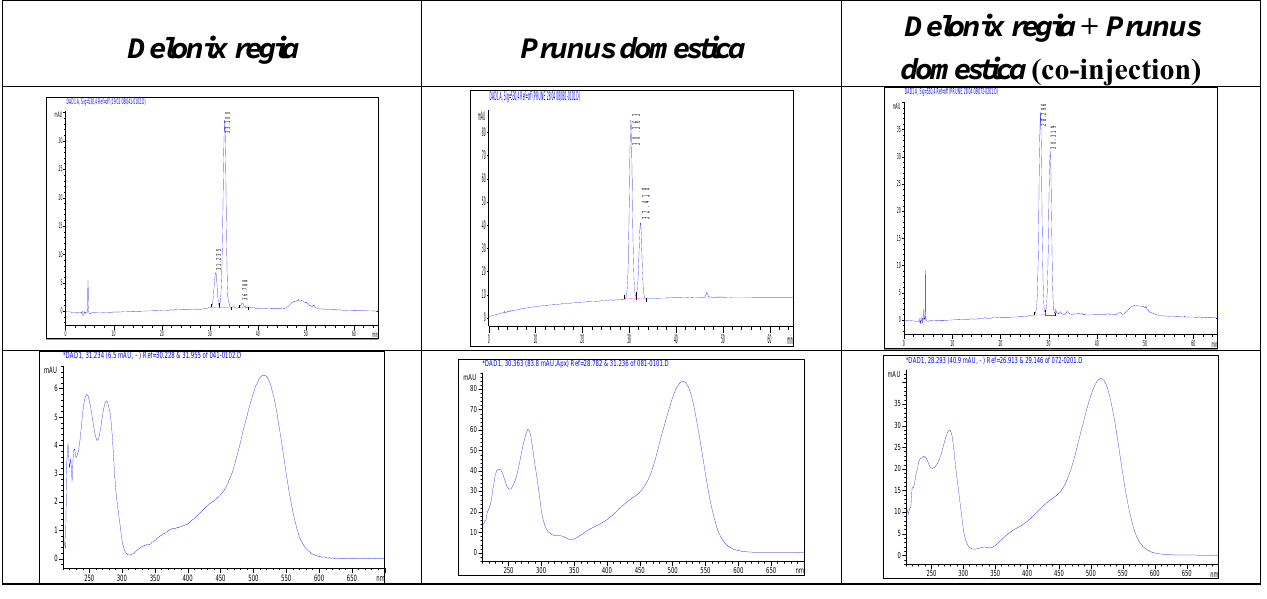
Delonix regia + Prunus domestica